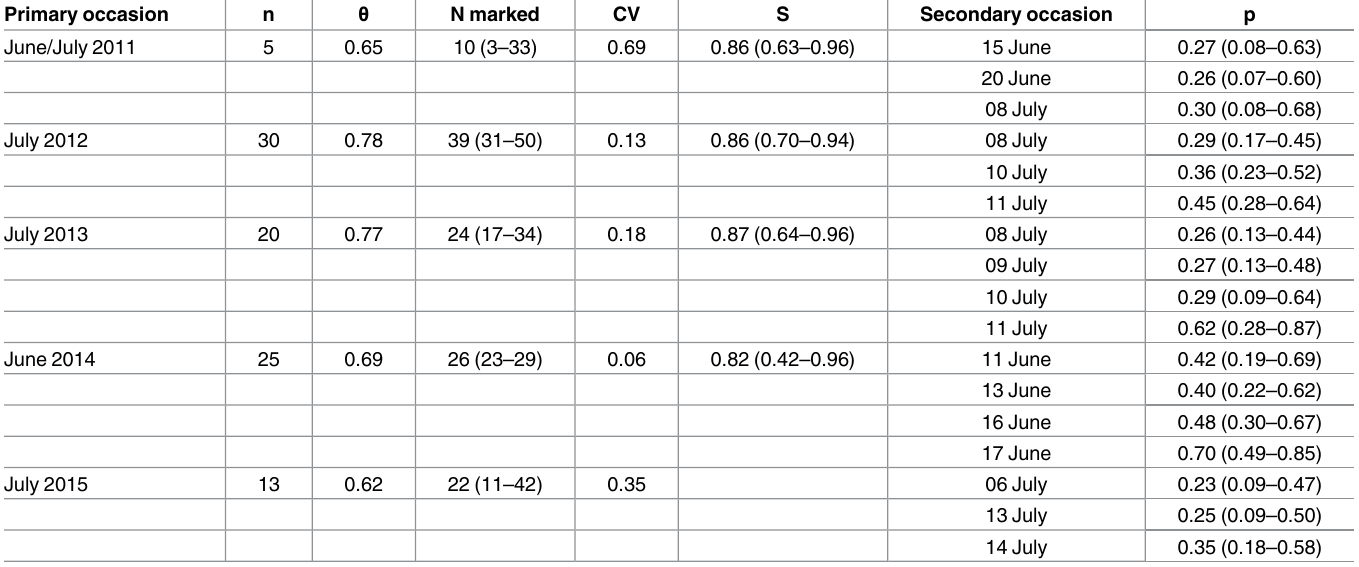
Table 6. Parameter estimates(with 95% confidence interval) for best model for the bottlenose dolphin dataset; n = number of photo-identified indi- viduals (D1), θ = mark ratio, N marked = estimated abundance of D1 individuals; CV = coefficient of variation, S = apparent survival probability; p = capture probability.